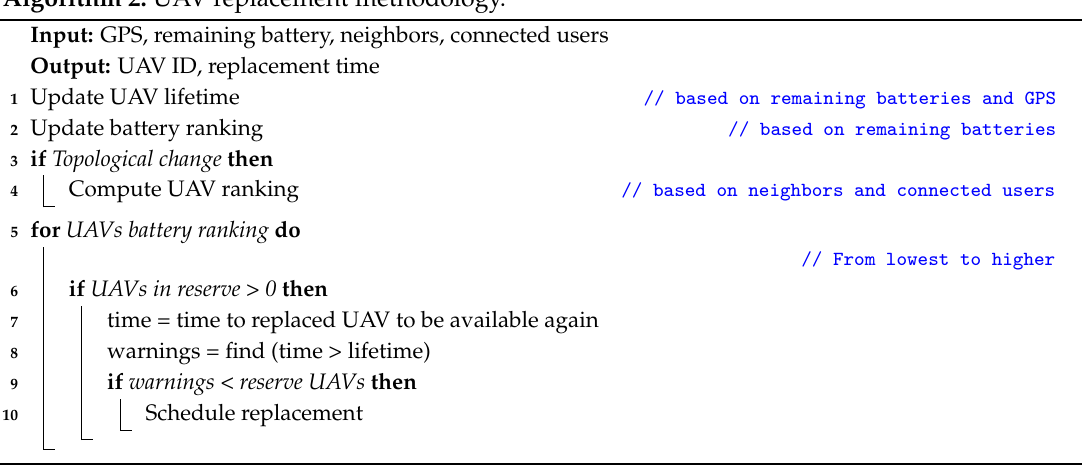
Algorithm 2: UAV replacement